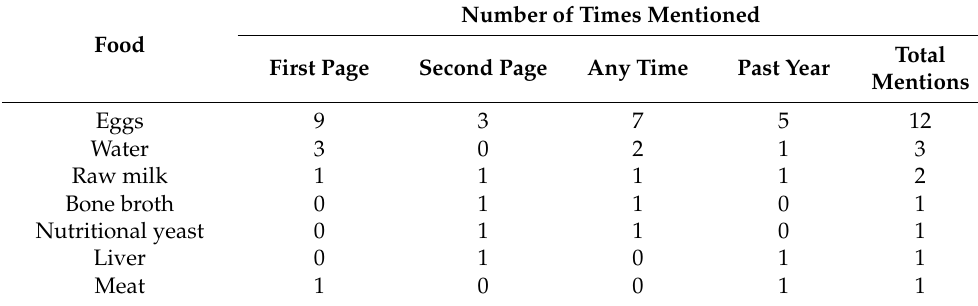
Table 9. Classification of other animal-based foods and other foods by the number of times that were mentioned on selected web